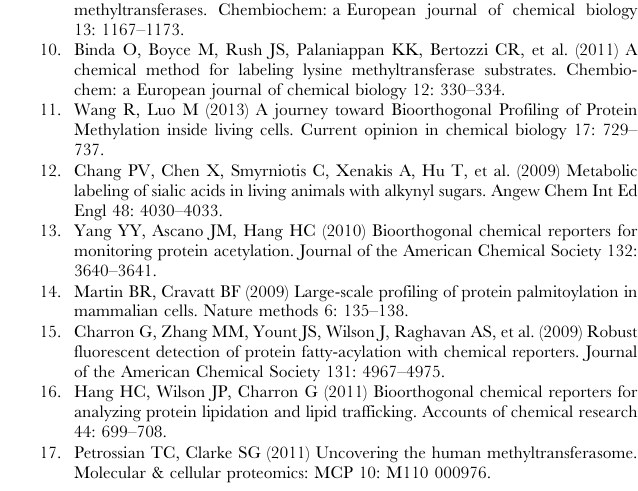
Table S2 Summary of proteomic identification of METTL21A potential substrates. Table S3 Summary of proteomic identification of METTL10 potential